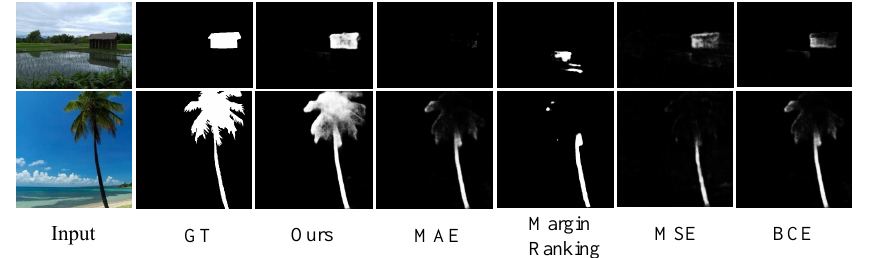
Figure 5. Qualitative results obtained by using different loss functions. Our results are more visually consistent with the ground-truth